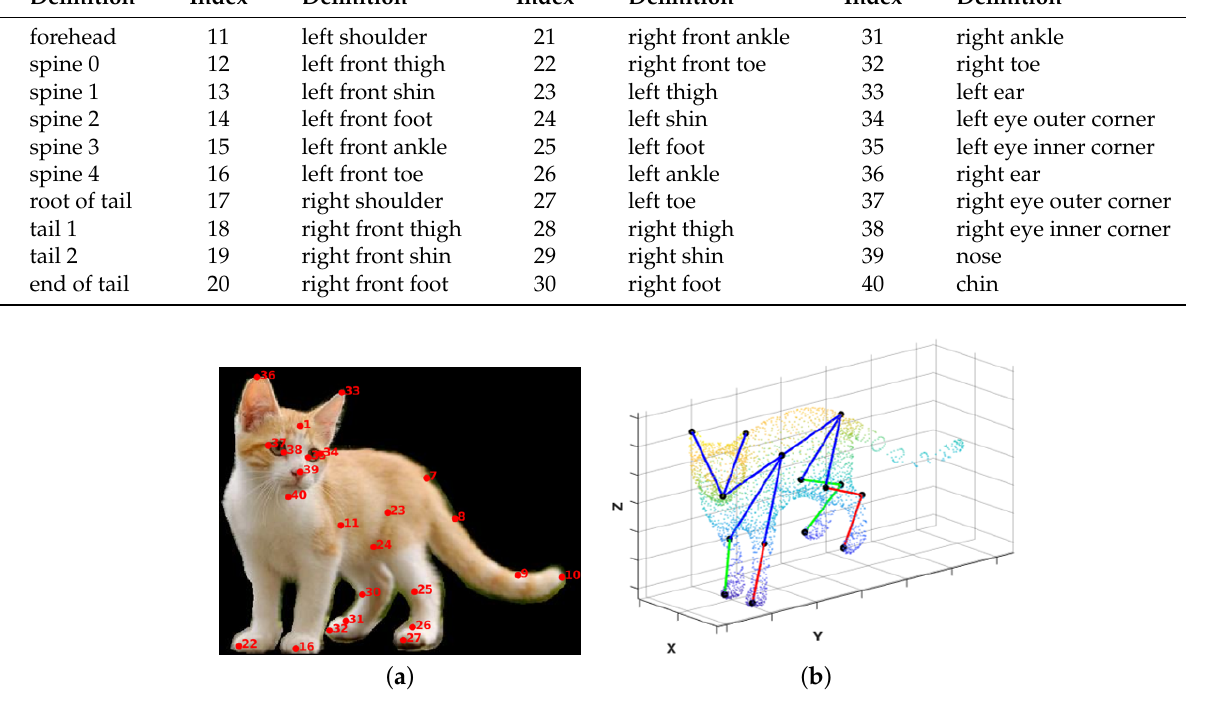
Figure 3. Pose definition: ( a ) key points defined in [51]. The number represents the index of the key point, as shown in Table 1; ( b ) joints defined in [24] are represented by black points. The blue, red and green lines indicate the connections between the joints on the trunk, left limb and right limb,